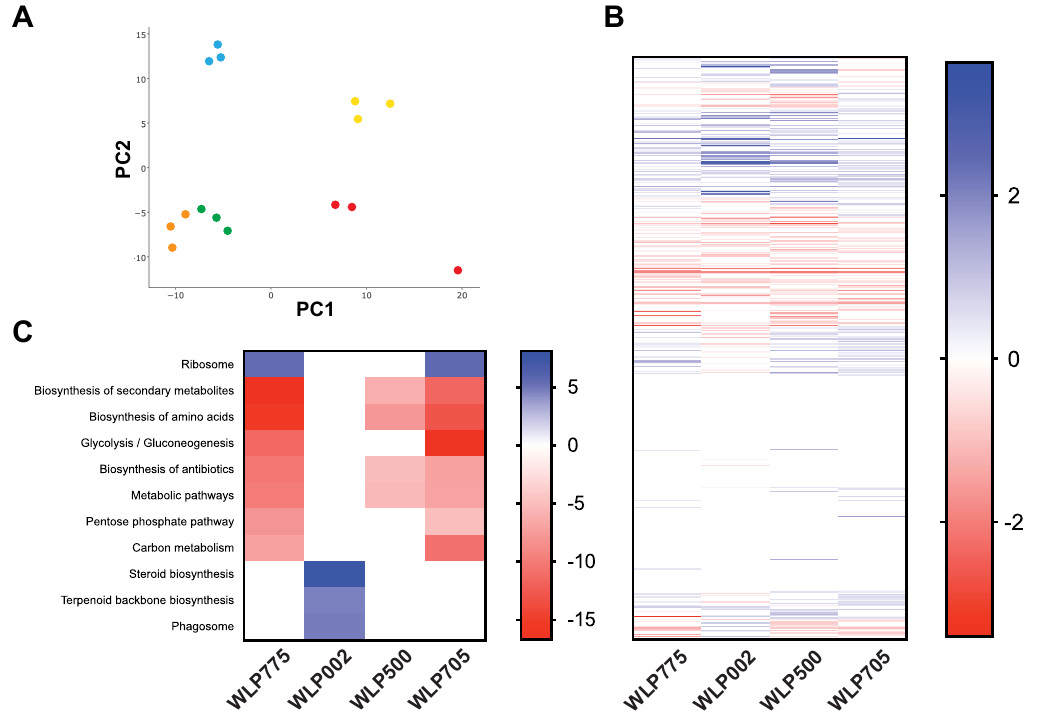
Figure 2. Whole cell proteome comparison between yeast strains. ( A ) Principle component analysis of whole cell proteome. Colored by yeast strain: BY4743 (red), WLP775 (green), WLP002 (yellow), WLP500 (blue) and WLP705 (orange). The first component (x-axis) accounted for 25.86% of the total variance and the second component accounted for an additional 20.51%; ( B ) heat map of differentially abundant proteins between designated yeast strains and laboratory BY4743. Values shown as log 2 (fold change) for proteins which were significantly different in abundance ( p < 10 − 5 ) between each yeast strain and BY4743; ( C ) heat map of significantly enriched pathways identified by DAVID analysis. Values shown as − log 2 of Benjamini corrected p -values for pathways which were significantly enriched ( p <